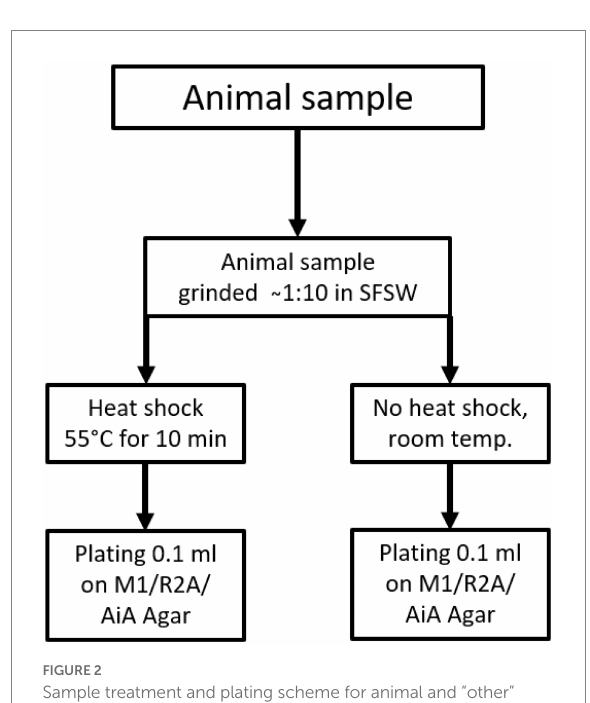
FIGURE 2 Sample treatment and plating scheme for animal and “other” samples, animal samples were plated on M1, AiA & R2A isolation